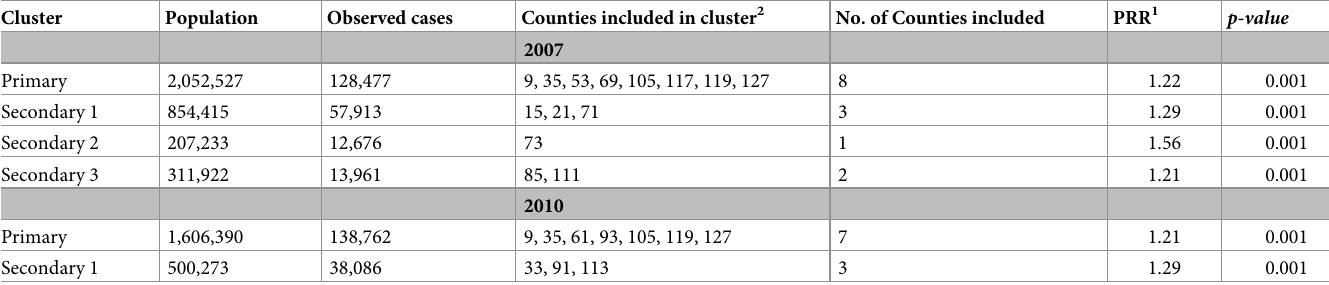
Table 4. Purely spatial clusters of High Diabetes Self-Management Education (DSME) program participation rates in Florida, 2007 and 2010. Cluster